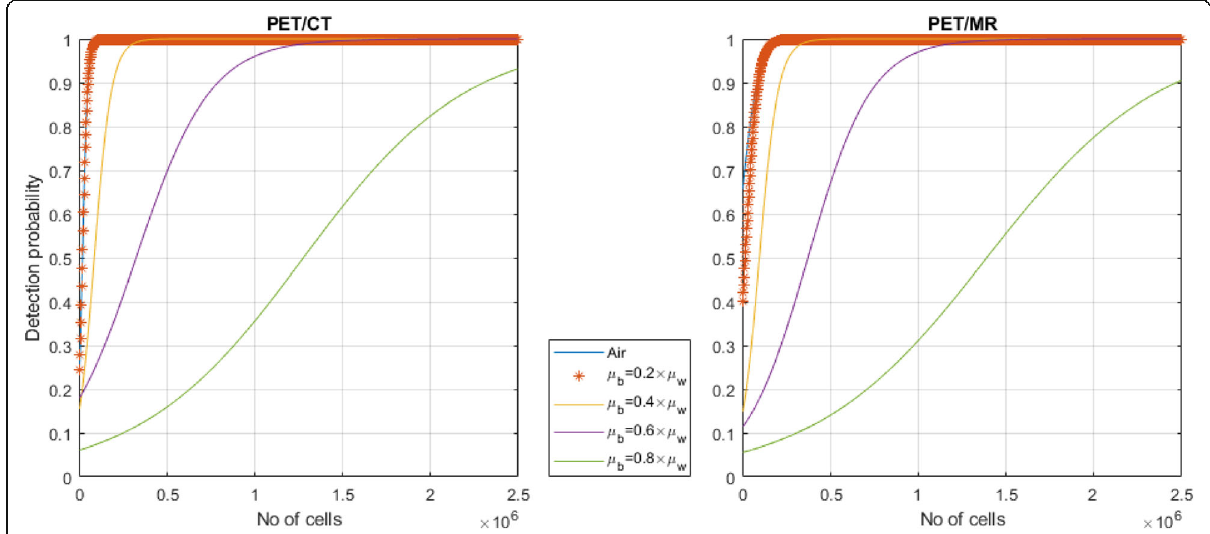
Fig. 6 Detection probability of 89 Zr-labeled cell suspensions at different background levels for a PET/CT and b PET/MRI. μ w , μ b : mean radioactivity concentration in 89 Zr-containing wells and the background respectively